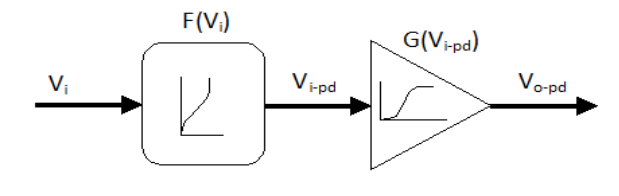
Fig. 10 Overall DPD system (Mekechuk et al., 2004).